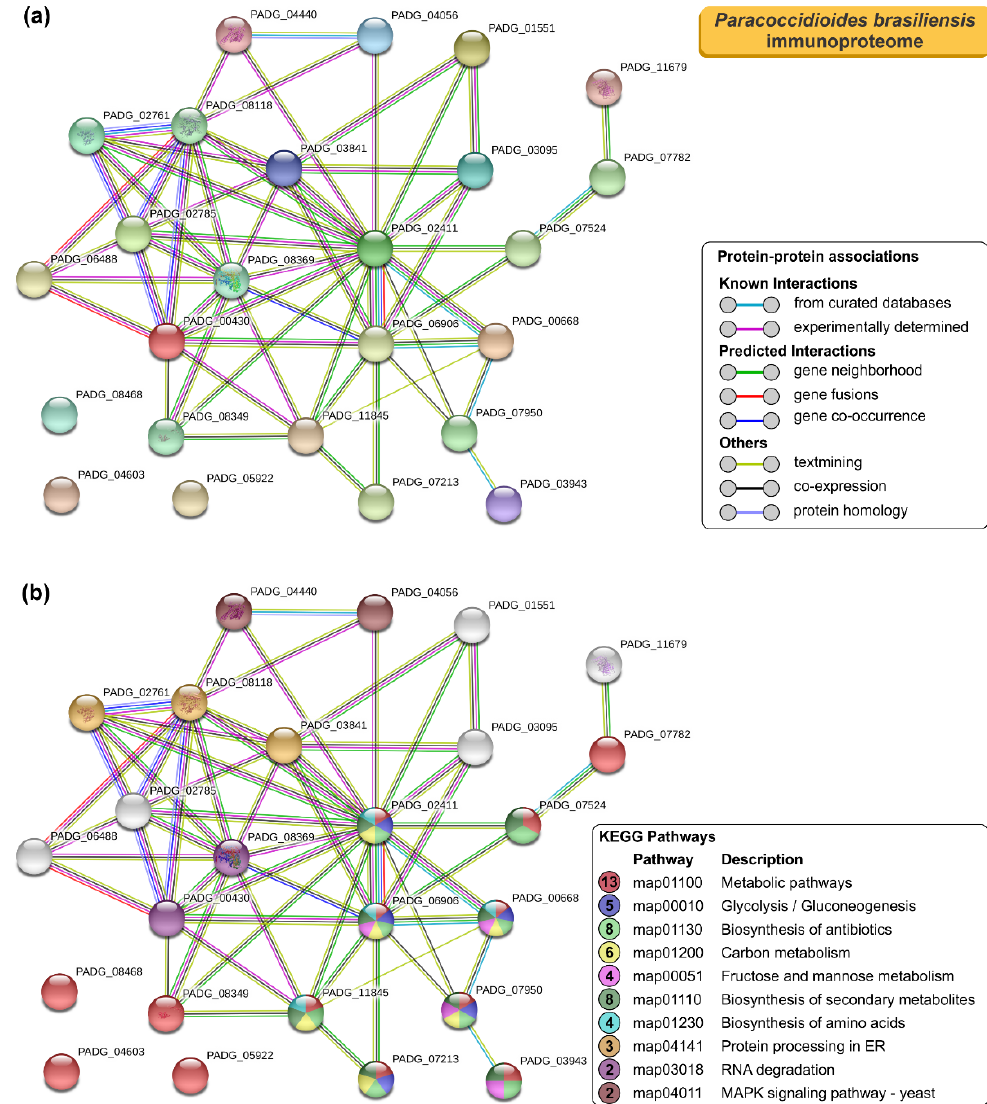
Figure 5. STRING analysis of Paracoccidioides brasiliensis immunoproteome. ( a ) A total of 25 immunoreactive proteins from P. brasiliensis were used as input for STRING analysis, and a network was built based on high confidence evidence from experimental protein–protein interaction (purple line) and curated (light blue lines) databases. Proteins are indicated by nodes labeled with the encoding gene symbol (number of edges = 25) from P. brasiliensis as a model. ( b ) Classification of proteins based on KEGG pathways. Protein–protein interactions’ enrichment p -value < 1.0 × 10 − 16 .